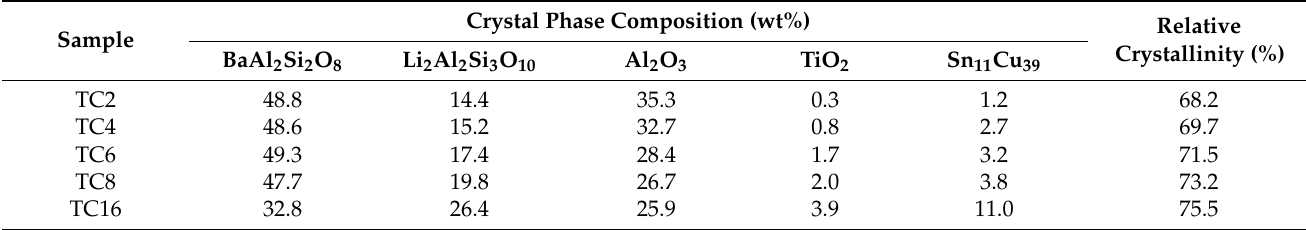
Table 2. Phase content and relative crystallinity calculated from XRD.